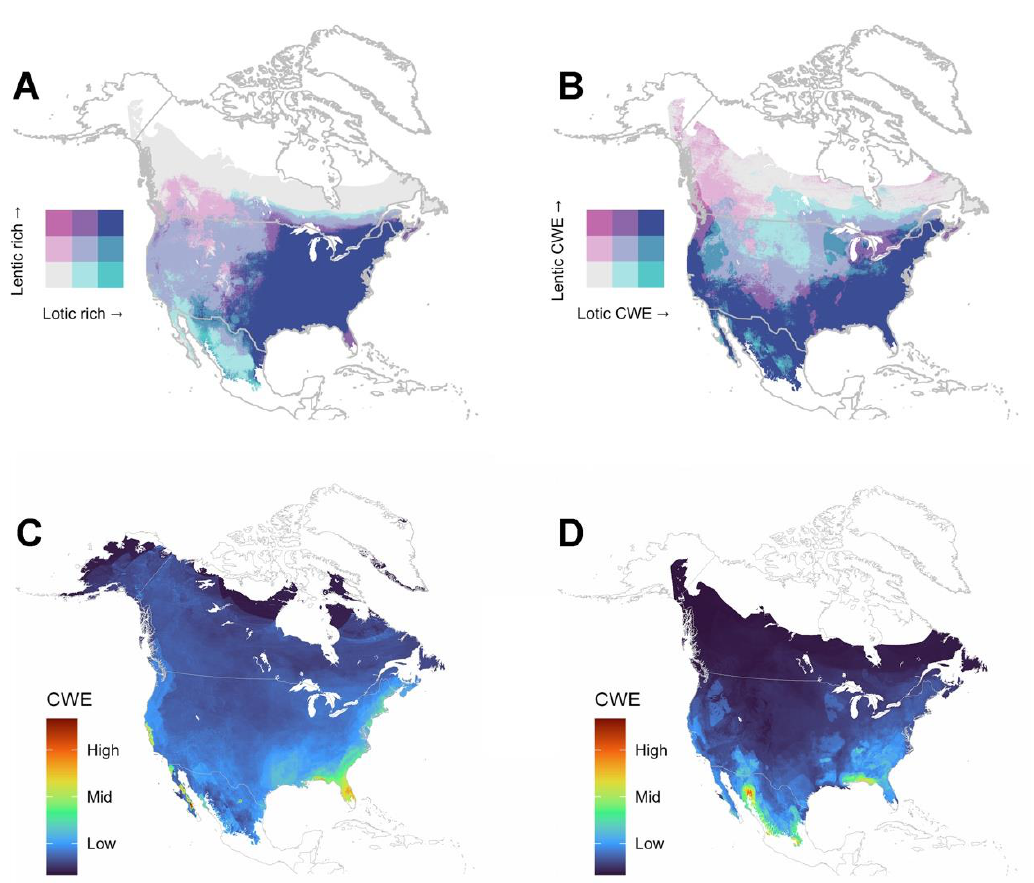
Figure 3. Species richness and corrected weighted endemism for aquatic habitats used by Odonate species in the Nearctic realm. ( A ) Bivariate plot showing distribution of richness for lotic-dependent and lentic species; ( B ) bivariate plot showing distribution of corrected weighted endemism (CWE) for lotic-dependent and lentic species; ( C ) corrected weighted endemism (CWE) for lentic-dependent species; ( D ) corrected weighted endemism (CWE) for lotic-dependent species.